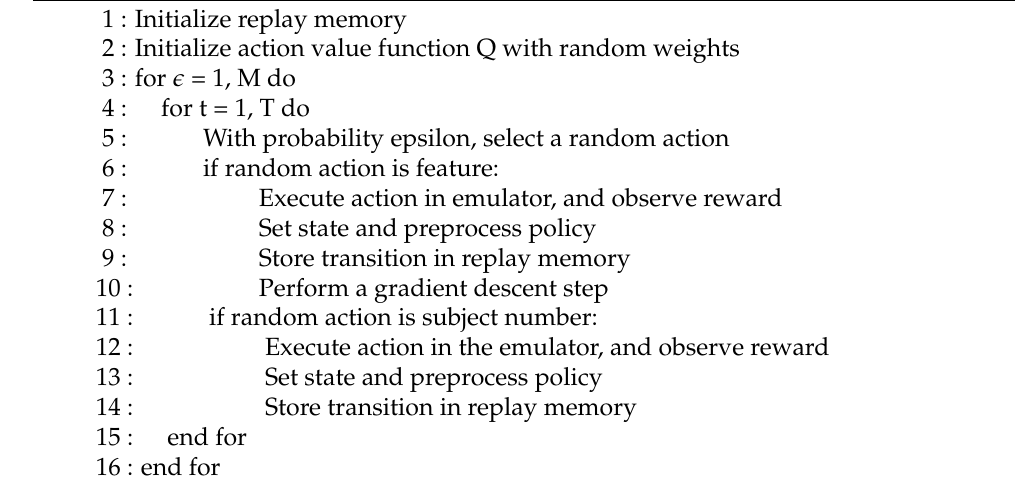
Algorithm 1 Procedure of DQN Optimizer and